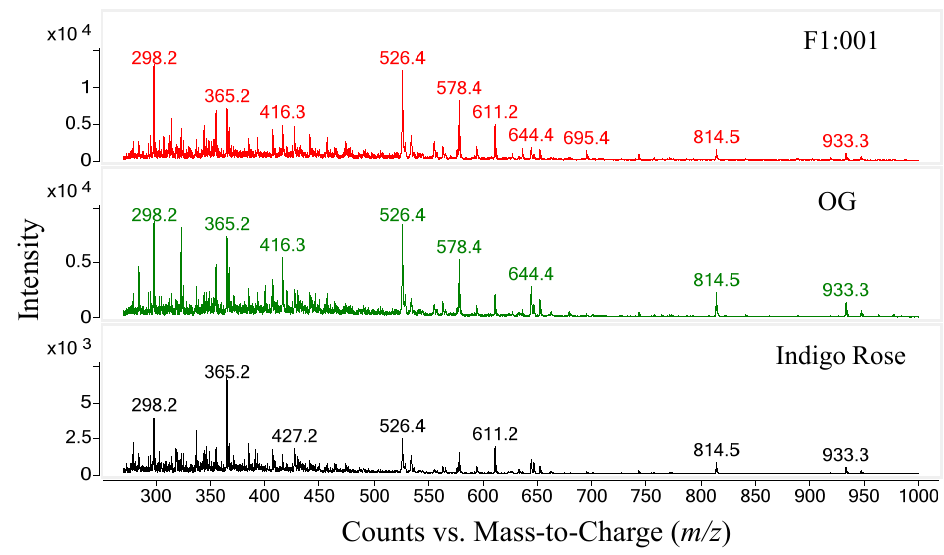
Figure 2. Chromatograms of [M+H]+ ions in three varieties of black cherry tomatoes.